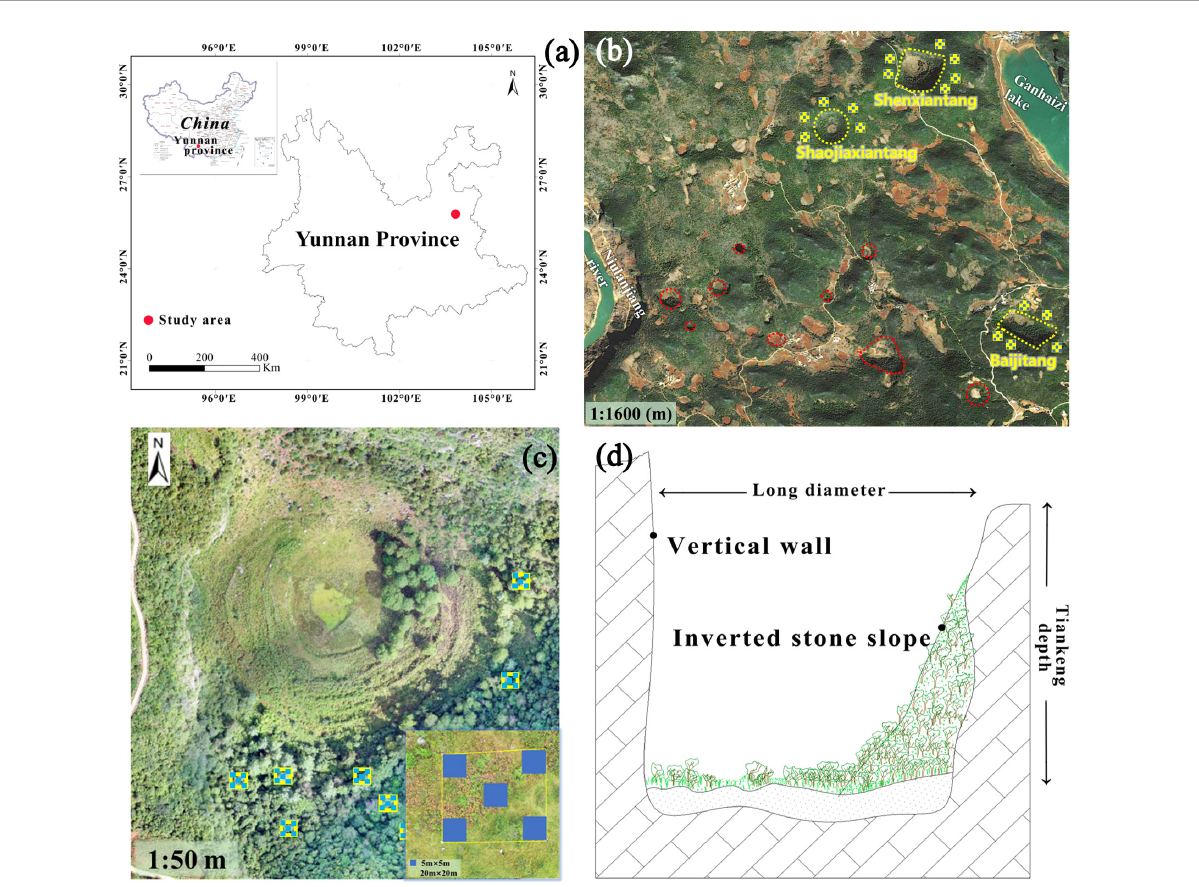
FIGURE1 Study region (a,b) , top view of karst tiankengs with sample design (c) , and longitudinal profile of karst tiankeng (d) . (a) Map source: Natural Resources Standard Map Service Review Number: GS(2019)1686. Sampled area are highlighted in yellow (b) , among them, circle: karst tiankeng groups, yellow circle: karst tiankeng occurring in the study area, squares: schematic of surface sample.